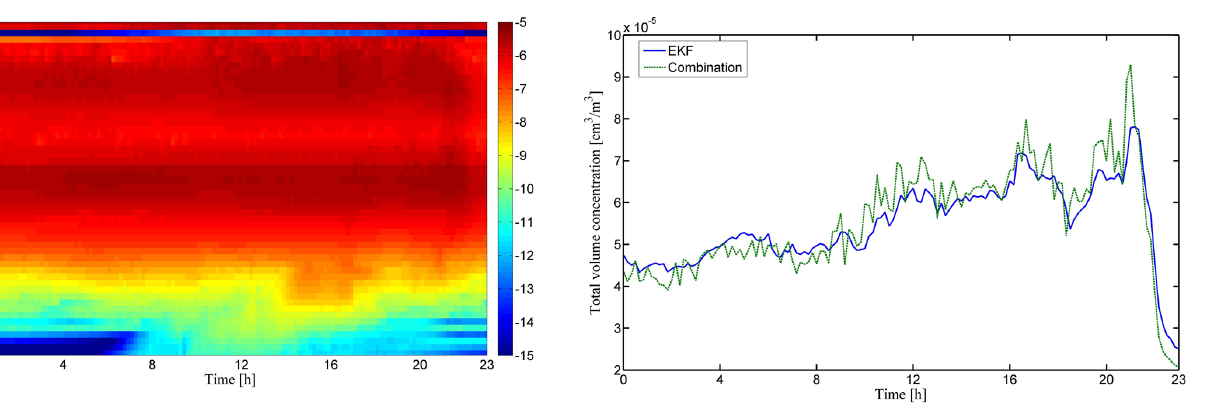
Fig. 2a. Particle volume size distribution obtained with EKF using Fig. 2c. The total volume concentrations for particles larger than ) on 7 May 2007 from SMEAR DMPS and APS observations ( x V DA 3nm for x V (blue, solid) and x V com (green, DA II in Hyyti¨al¨a, Finland. Note that the particle volume concentrations are only presented from 10 − 15 to 10 − 5 cm 3 m − 3 . The color bar values are given as exponents of 10.